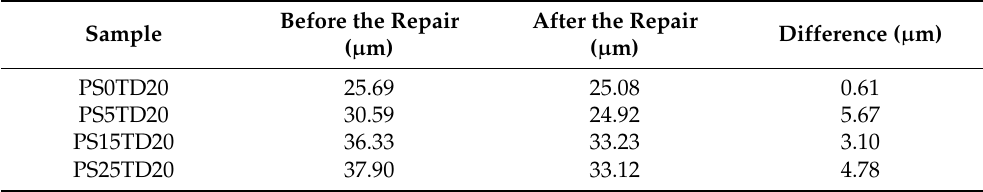
Table 5. Restorative effect on the surface coating of Ebiara solid boards.